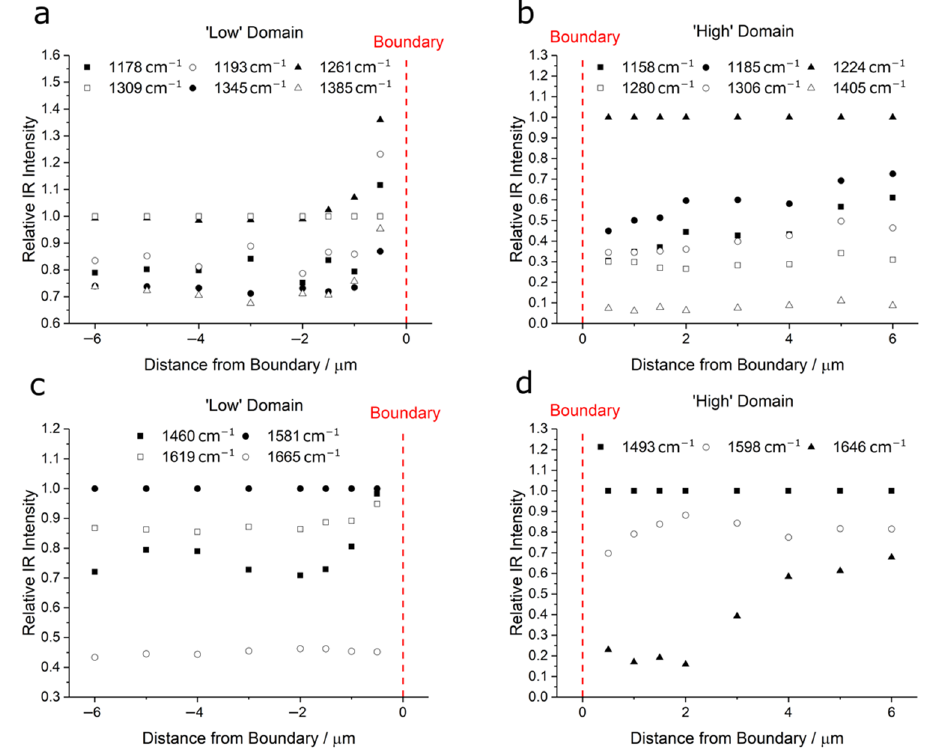
Figure 4. Analysis of the AFM-IR intensities of the PPB domains showing the relative intensities of the bands in the spectra presented in Figure 3 for the 1134–1440 cm − 1 ( a , b ) and the 1460–1700 cm − 1 ( c , d ) spectral regions within ‘low’ ( a , c ) and ‘high’ ( b , d ) domains. The intensities are normalised to the strongest band in the spectrum furthest from the boundary (i.e., d = − 6 and d = +6 μ m for the ‘low’ PBI and ‘high’ PEEK domains, respectively) within each of the two spectral regions investigated (each of which was covered by an individual QCL) i.e., to the band at 1309 cm − 1 in ( a ), 1224 cm − 1 in ( b ), 1581 cm − 1 in ( c ), and 1493 cm − 1 in ( d ).